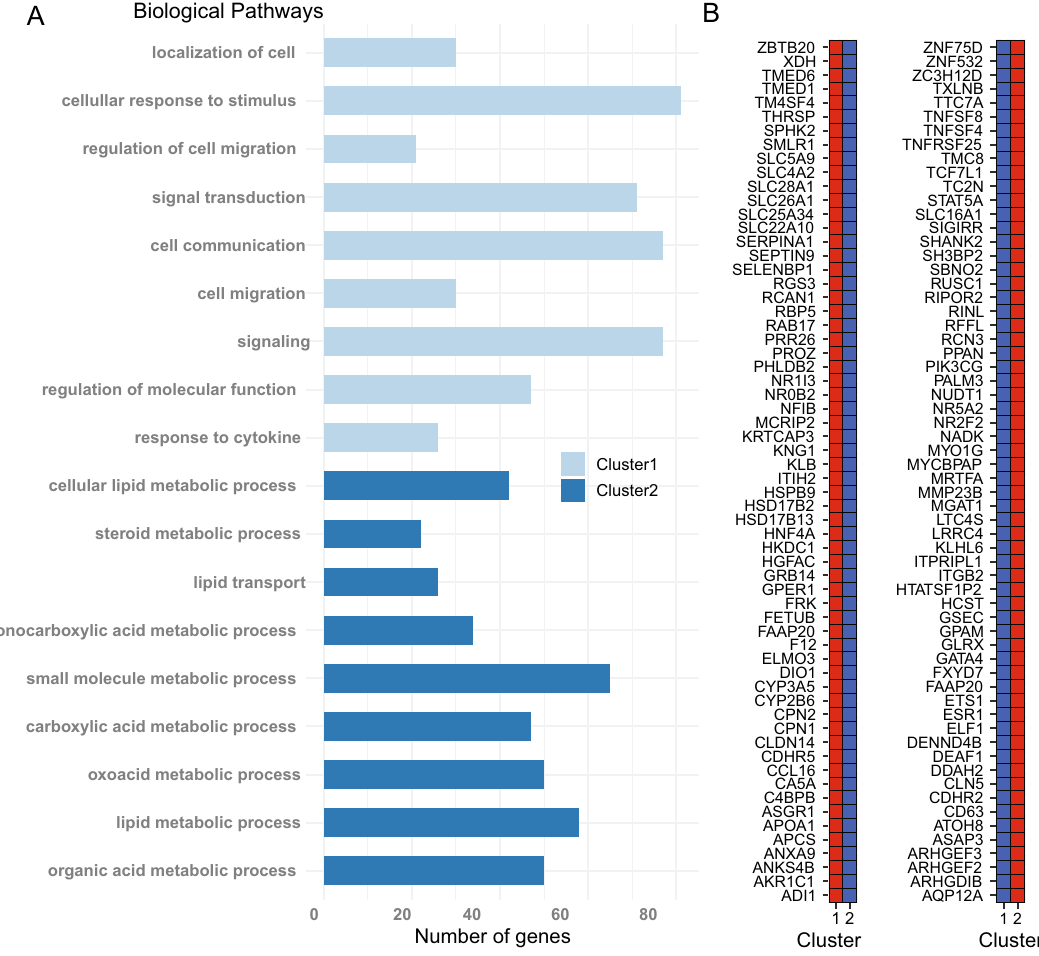
Figure 4. Cluster specific gene ontology pathway analysis. ( A ) Result from gene ontology pathway analysis. Genes associated with a hypomethylated DMR in cluster 1 or cluster 2 and located in a promoter and/or TSS region, were used as input for GO pathway analysis. The most significant biological pathways found for cluster 1 and cluster 2, respectively are shown. Metabolic pathways were identified in cluster 2, indicating hepatocytes (HCs). For cluster 1 the identified GO pathways did not reveal a specific cell type ( B ) A subset of the genes with DMRs in promoter regions. The DNA methylation status of the DMRs in each respective cluster are shown (low methylation = blue, high methylation =